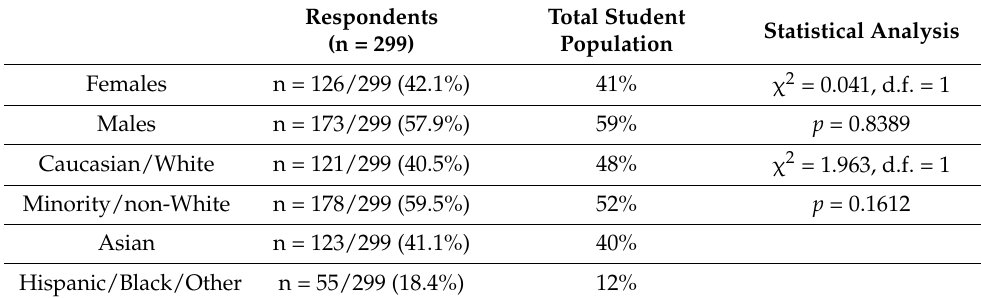
Table 1. Demographic characteristics of dental student participants.